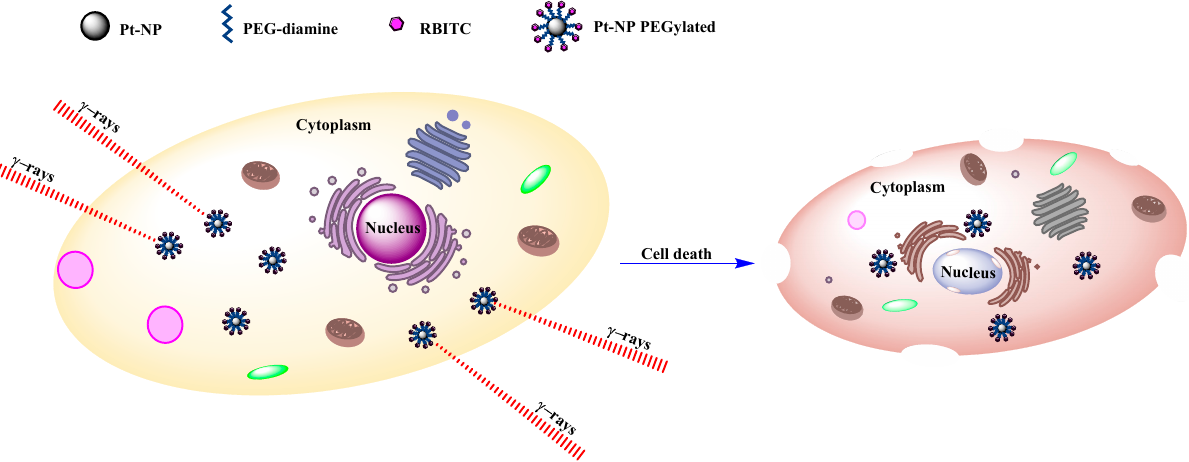
Figure 2. Gamma-ray-induced cell death amplified by PEGylated PtNPs.